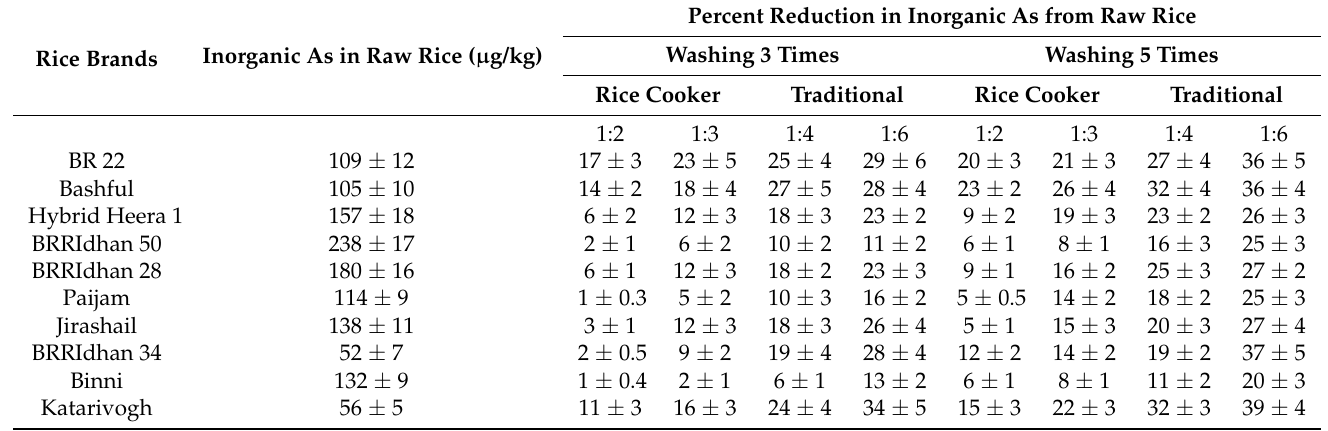
Table 2. Percent reduction in inorganic As from raw rice due to different washing and cooking methods. Percent Reduction in Inorganic As from Raw Rice Washing 3 Times Washing 5 Times Rice Brands Inorganic As in Raw Rice ( µ g/kg) Rice Cooker Traditional Rice